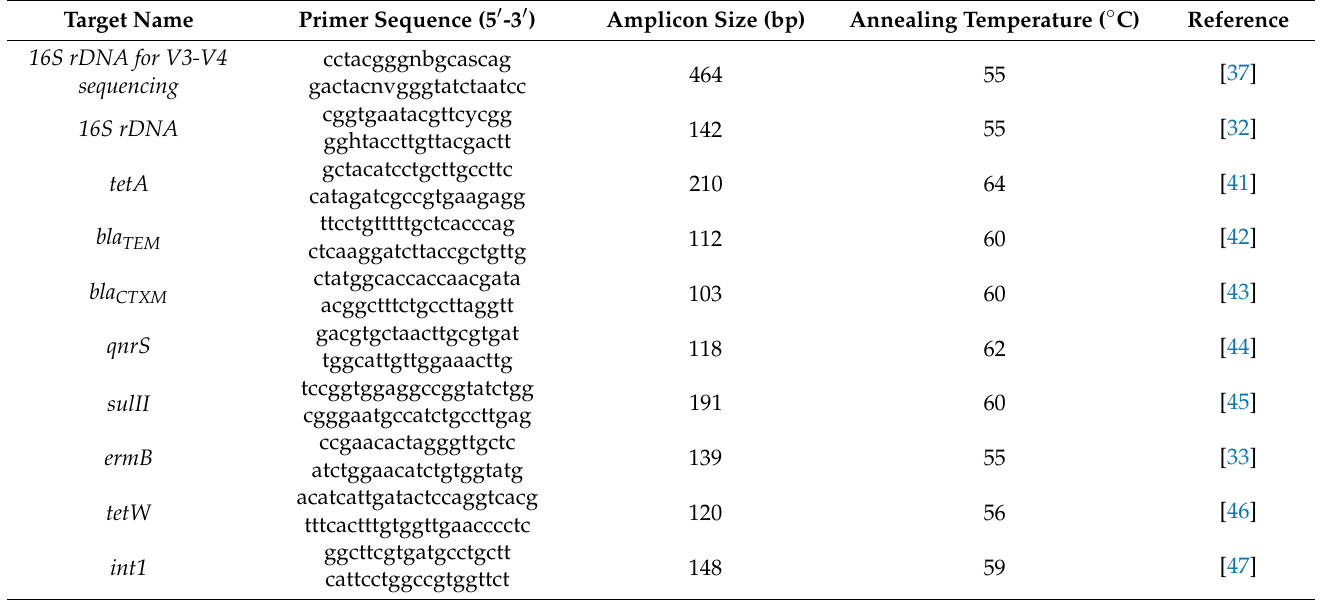
Table 1. List of primers used in this